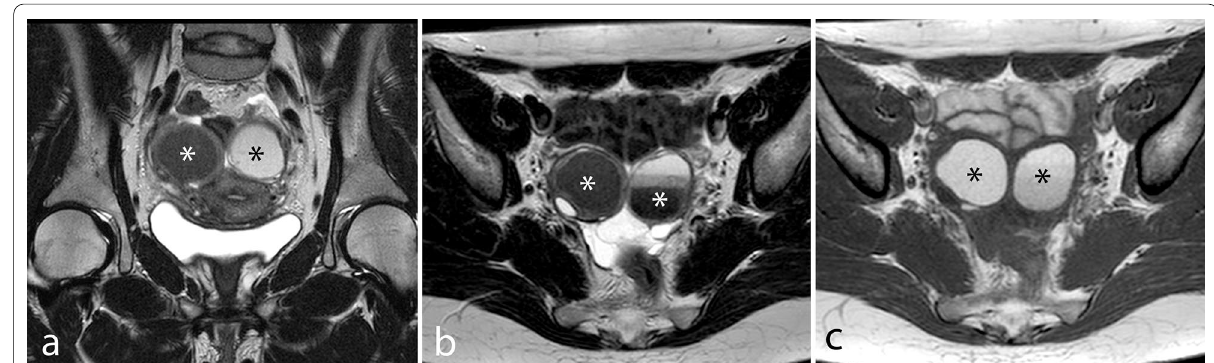
Fig. 4 Bilateral OMA. TSE T2 coronal ( a ) and axial ( b ) images and TSE T1w axial image ( c ). Bilateral endometriomas; the left-sided endometrioma shows a stratified aspect in b (shading sign). Of note, the ovaries are prolapsed in the pouch of Douglas, touching each other at the midline (kissing ovary sign)